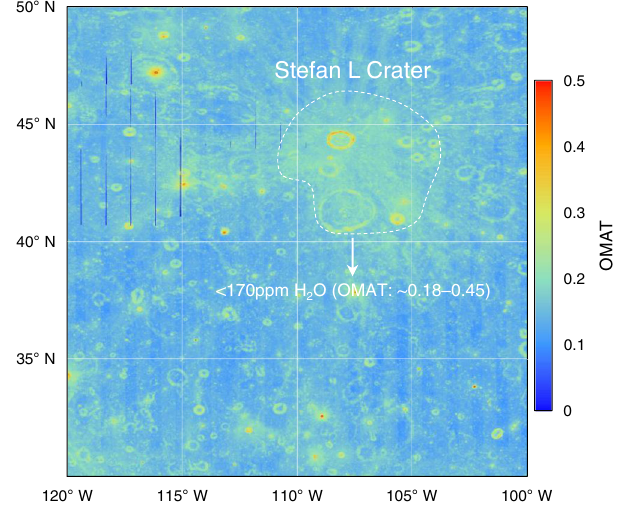
Fig. 5 | Optical maturity (OMAT) image for Stefan L crater and its surrounding areas. The OMAT values were derived from Lemelin et al. 44 . The dashed area indicates the Stefan L Crater with larger OMAT